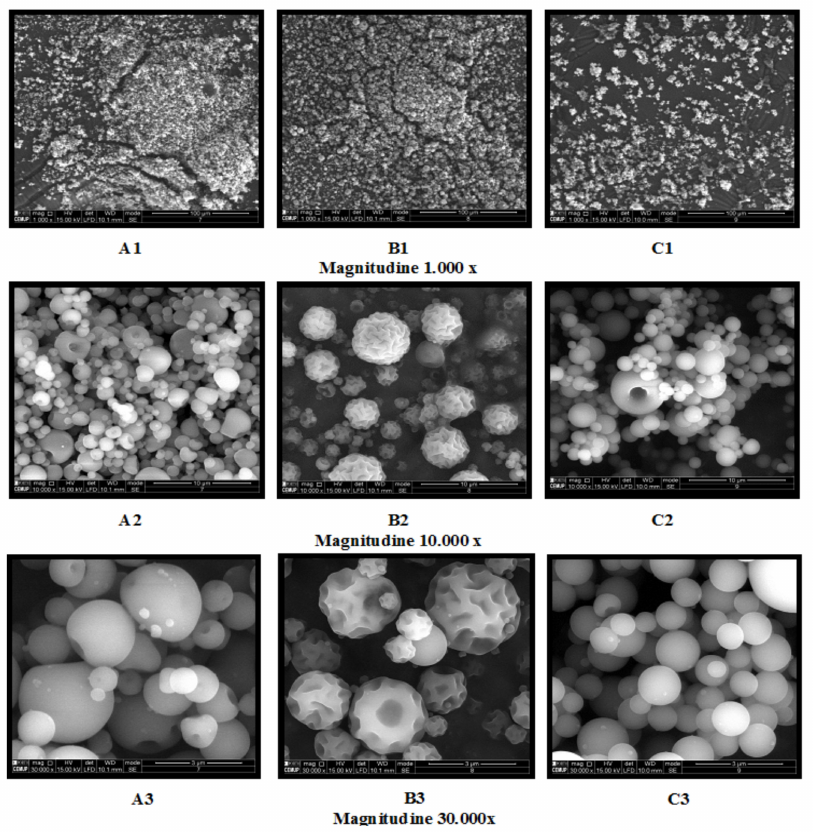
Figure 3. SEM images of alginate ( A1 – A3 ), chitosan ( B1 – B3 ), and modified chitosan ( C1 – C3 ) micro particles obtained by spray-drying (beam intensity (HV) 1000 kV, distance between the sample and the lens (WD) less than 12 mm).